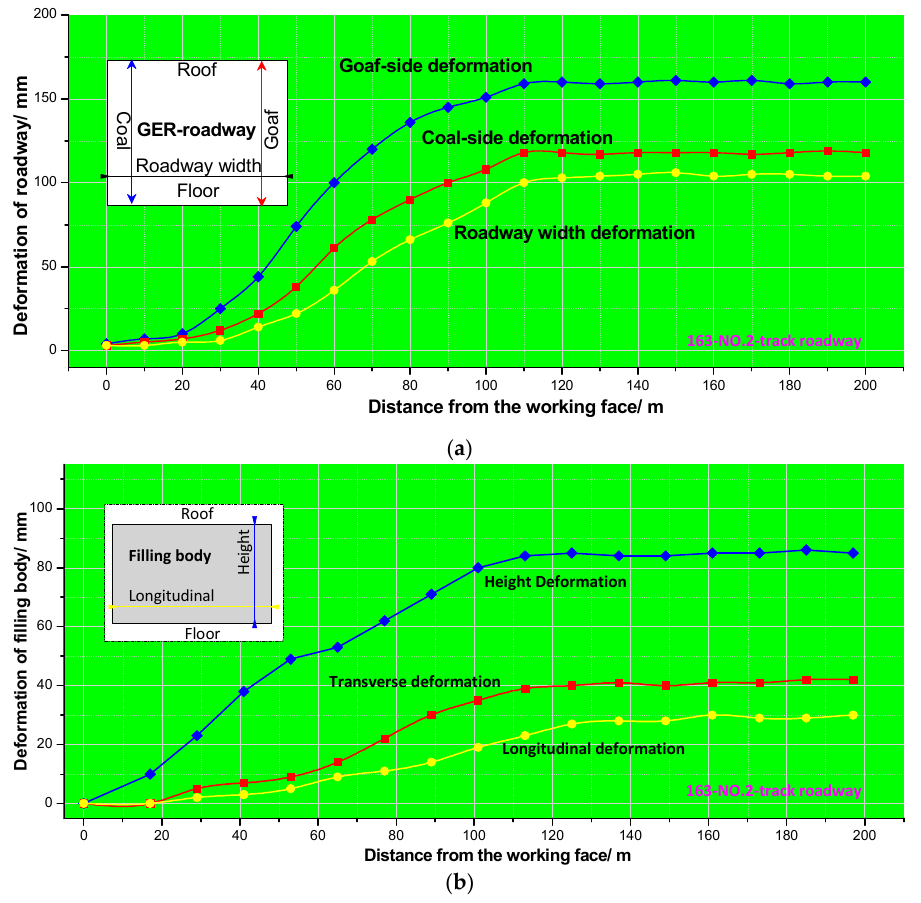
Figure 16. Field deformation observation: ( a ) deformation of roadway surrounding rock and ( b ) deformation of filling body.